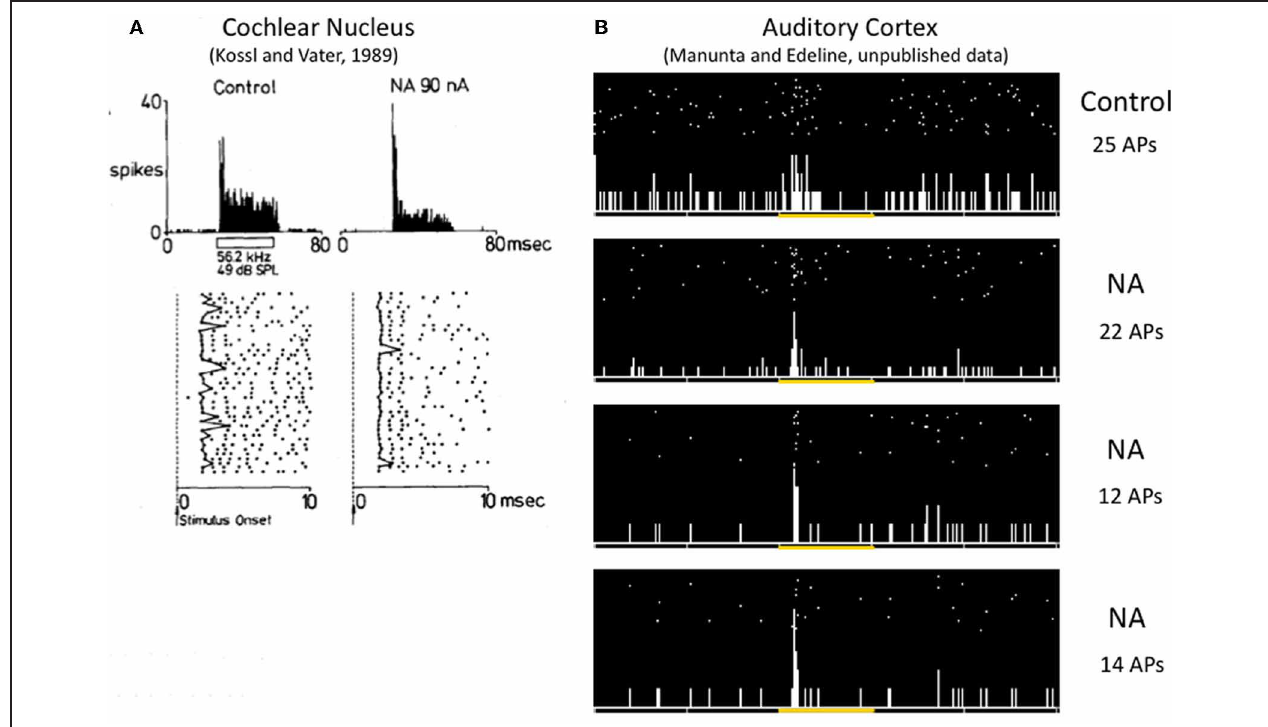
(B) In the auditory cortex, iontophoretic application of NE (1s pulses of NE repeated 30 times) at the vicinity of this cell transformed a weak disorganized response into a brief phasic response, mostly by reducing the jitter of the first spike latency (unpublished results from Manunta and